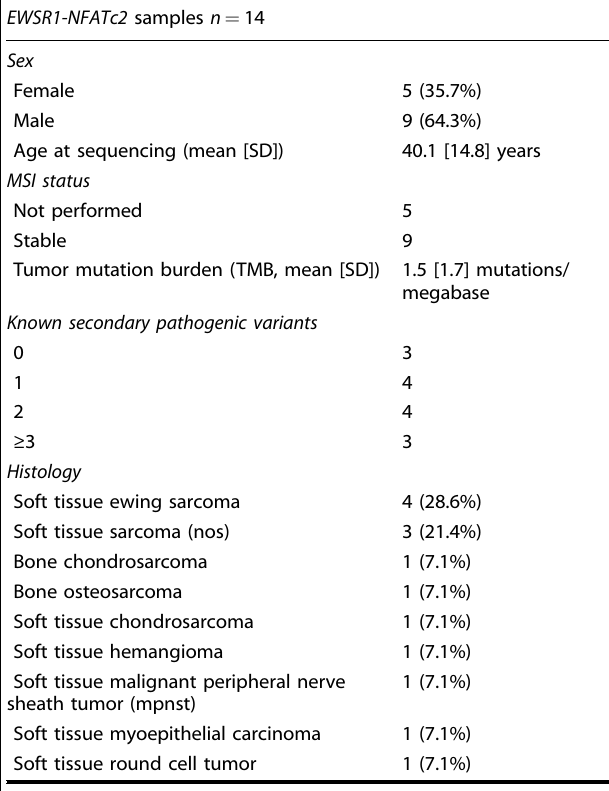
Table 1. Demographics of EWSR1-NFATc2